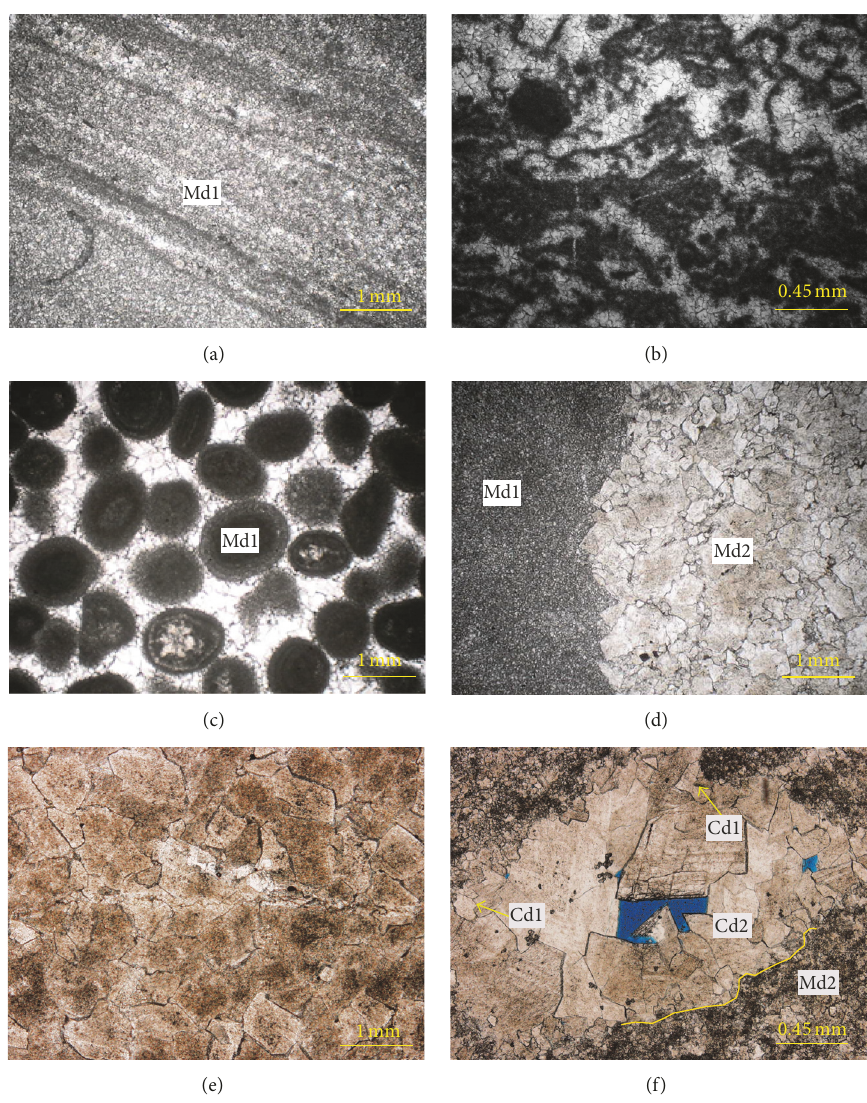
Figure 7: Photomicrographs showing different types of dolomites in Cambrian strata in well TS1. (a) Dark-brown to black, organic-rich laminated microbial dolomite (Md1), 7690 m. (b) Photomicrographs of microbial boundstones in platform margin reefs. Note the well- preserved original microbial fabric (Md2), 7875.7 m. (c) Photomicrographs of fabric-retentive dolomite (ooidal grainstone) (Md2) cemented with thin fibrous (or bladed) and equant dolomite crystals, 7710m. (d) Very finely crystalline, fabric-retentive micrite (dolomicrite) (Md1) with medium-crystalline fabric-obliterative dolomite (Md2), 8030 m. (e) Medium to coarse crystalline fabric-obliterative dolomite (Md2), 7155 m. (f) Photomicrograph showing cement dolomites in the vug developed in the matrix dolomite: the initial medium-crystalline planar-s (subhedral) dolomites (Cd1) and subsequent coarse crystalline saddle dolomites (Cd2) which are characterized by curved crystal faces and undulose extinction. 7875 m. Note the relict pore space in vug center (blue